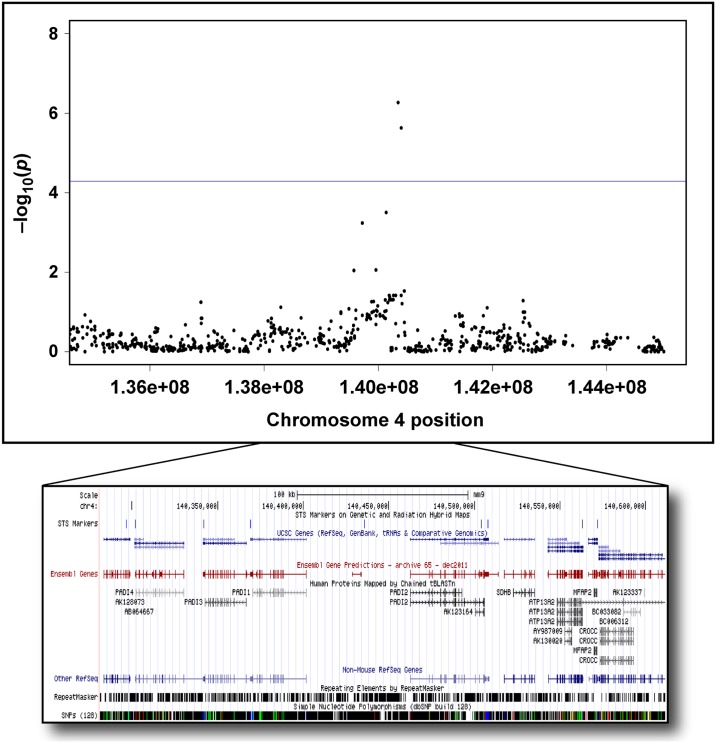
Regional plot of the Chr. 4 association in 42 common inbred mouse strains centered on the lead SNP (rs32857122) at the 5’-untranslated region of Padi2 locus.The top two black dots represents the most significant SNPs (p = 9.34 x 10−7 and 3.67 x 10−6 respectively). The positions of all reference sequence genes are plotted using genome locations from UCSC Genome Browser on Mouse July 2007 (NCBI37/mm9) Assembly.